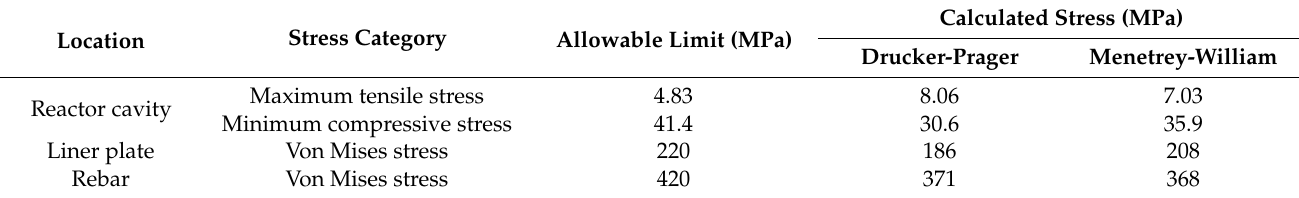
Table 6. Structural integrity evaluation of stress.